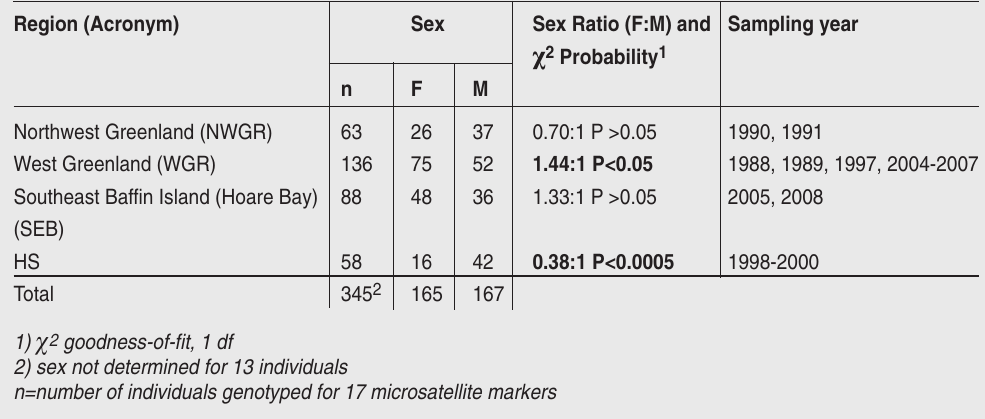
Table 1. Summary of samples from Hudson Strait, Southeast Baffin Island, West Greenland and Northwest Greenland used for genetic analyses. Bold= significant at the 5% level. Region (Acronym)